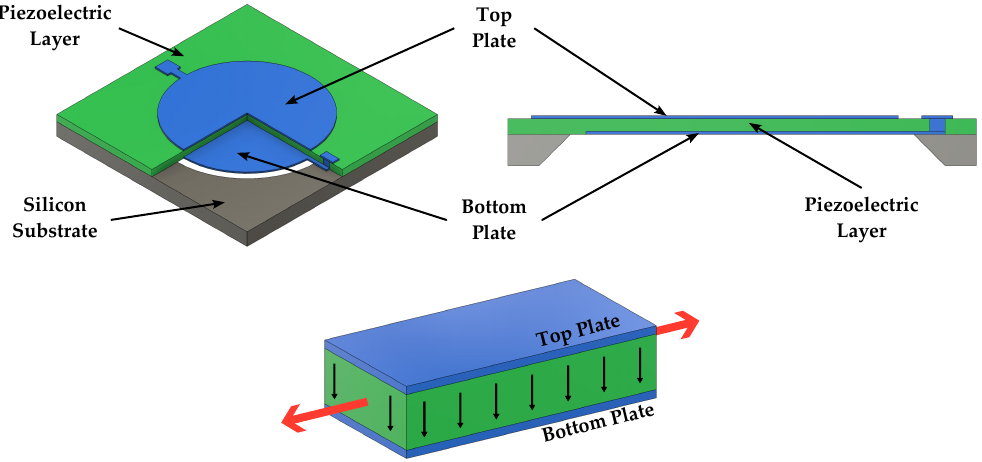
Figure 5. Schematic 3D view and cross section of a piezoelectric speaker exploiting the d 31 mode.